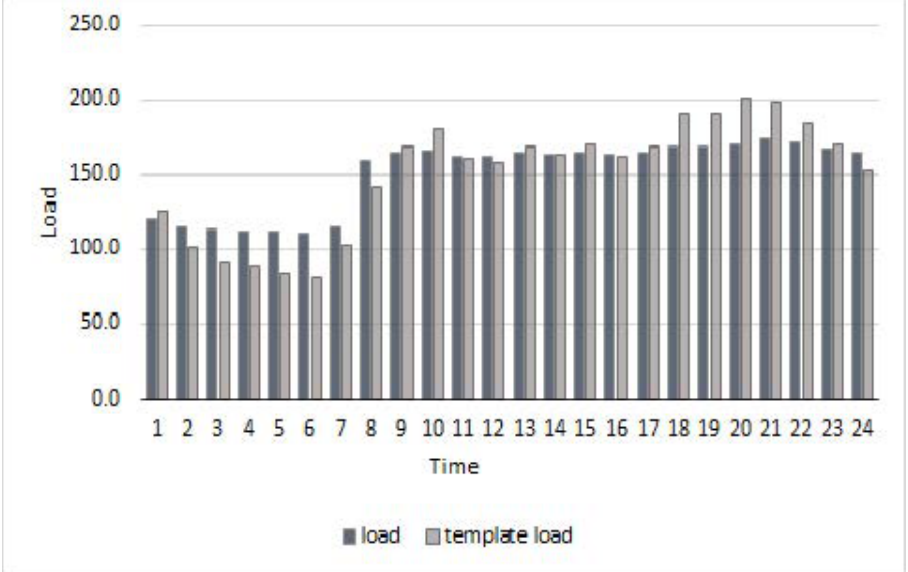
Figure 9. The aggregated load of the system load of the system before applying the optimal mecha- nism and